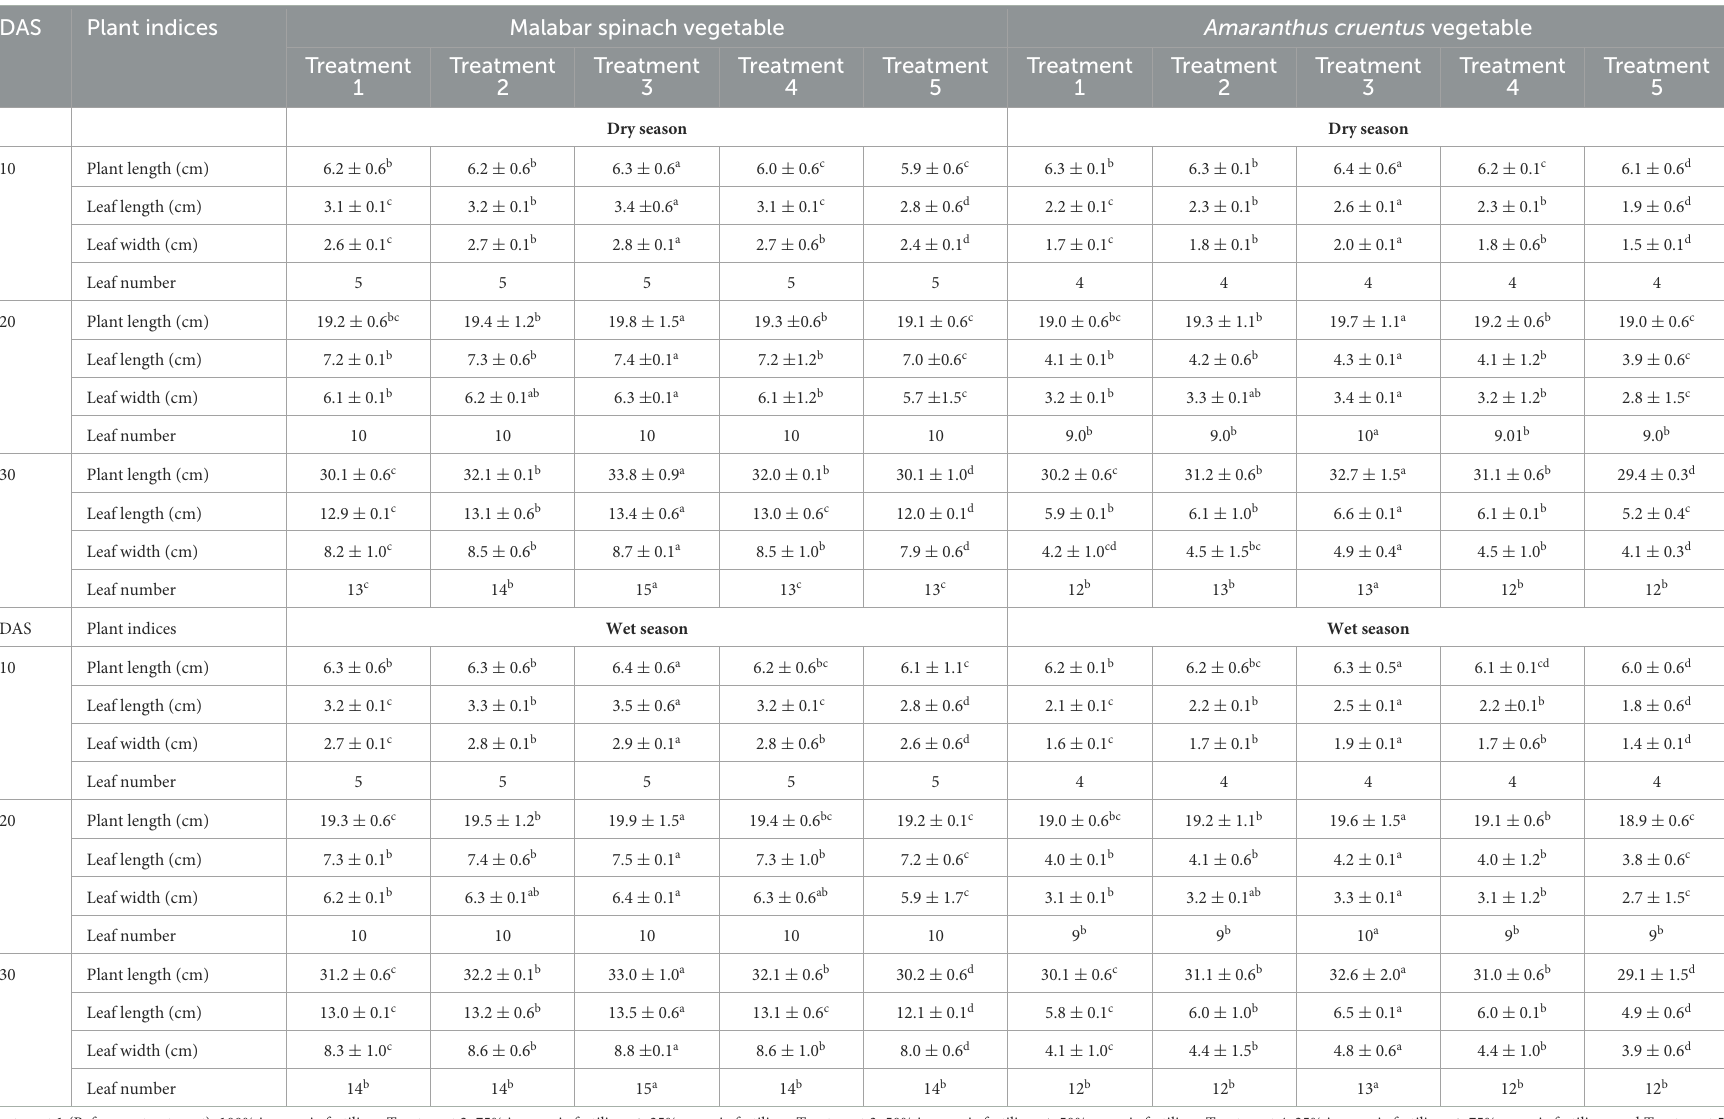
TABLE 4 Growth performance indices of Malabar spinach ( Basella alba L.) and Amaranthus cruentus ( Amaranthus L.) vegetables treated with experimental fertilizers in the wet and dry seasons at 10, 20, and 30-day after sowing (DAS).